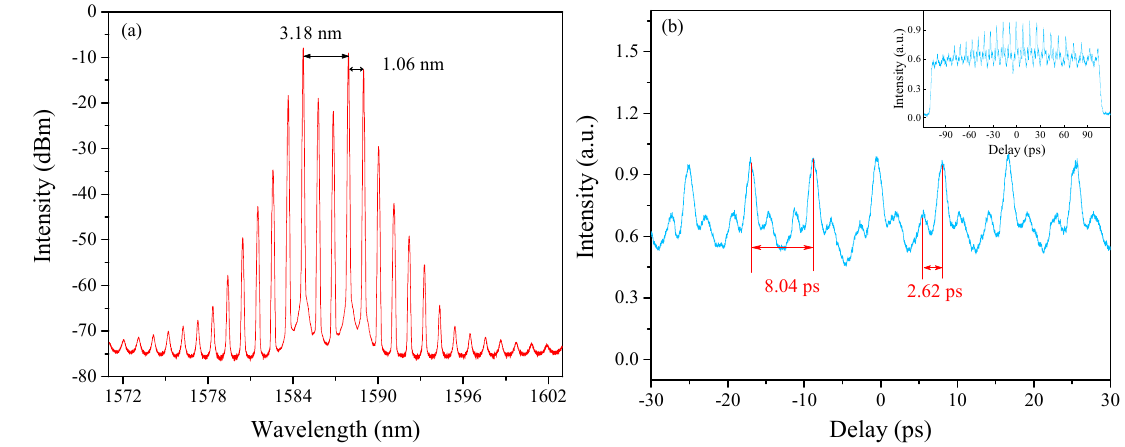
Figure 5. HRR Bound-soliton train. ( a ) Optical spectrum. ( b ) AC traces; the inset figure is full span measurement.